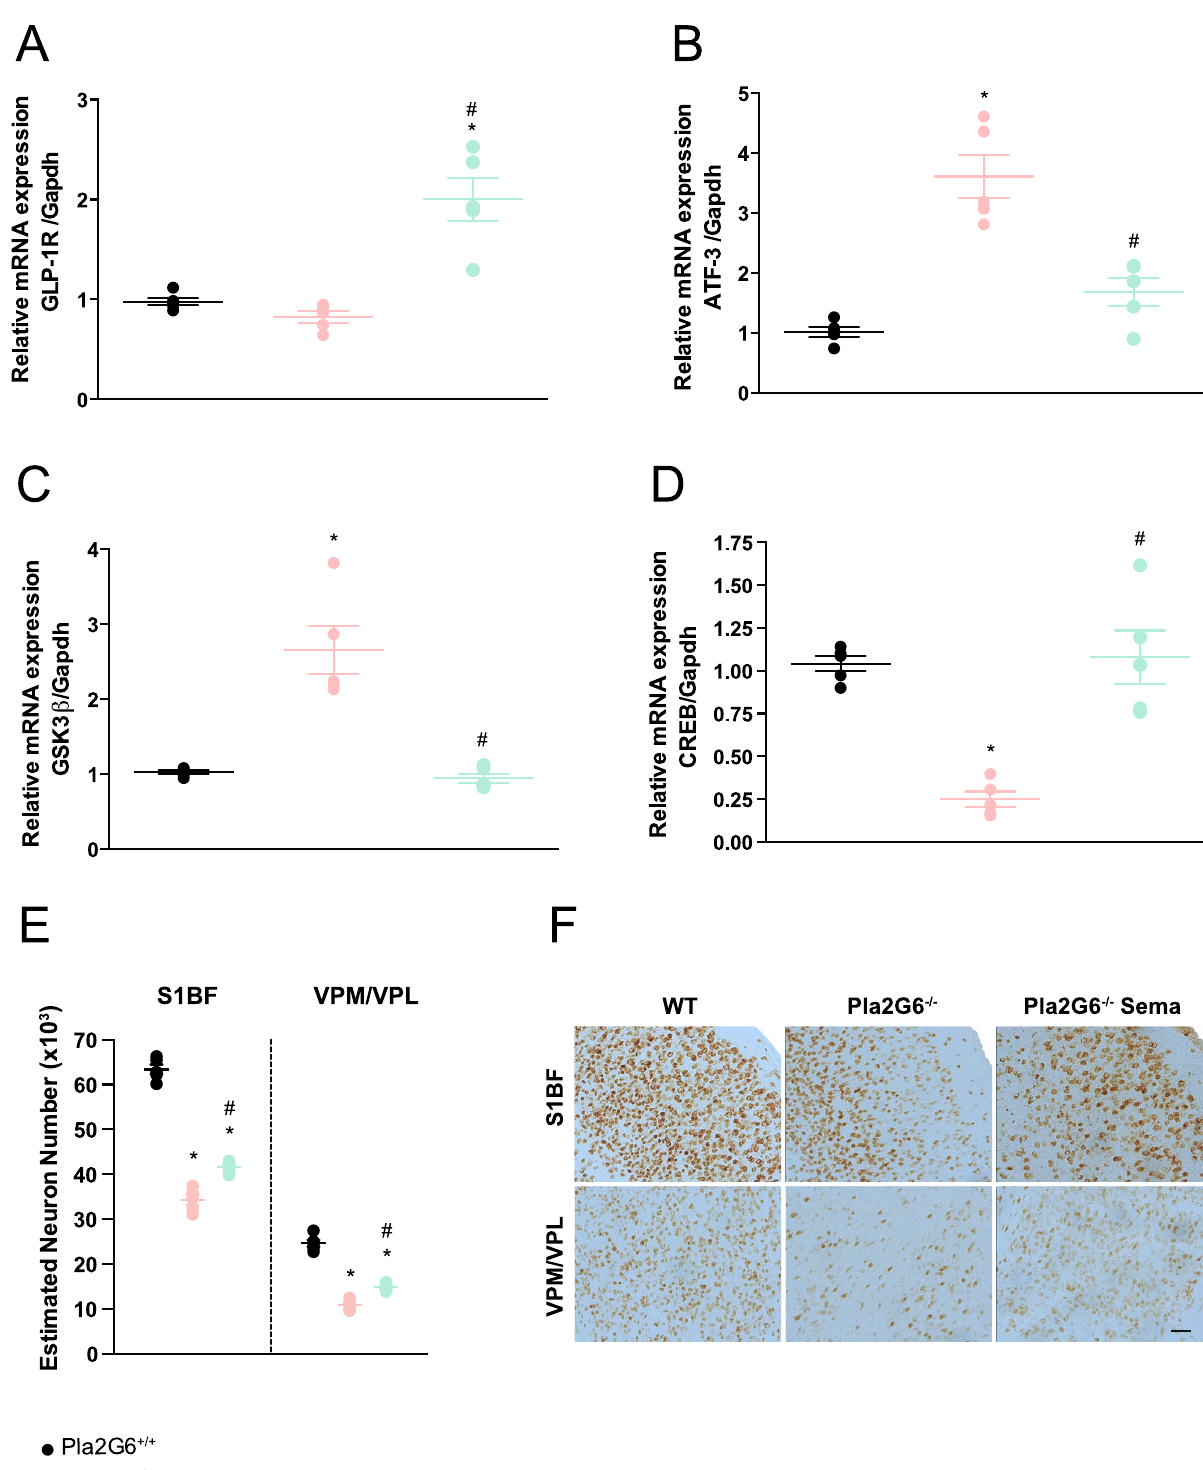
Figure 2. Semaglutide induces neuroprotection and reduces neuronal damage demonstrated by modulation of neuroprotective markers and neuronal damage markers. Relative quantification of ( A ) GLP-1R, ( B ) ATF-3, ( C ) GSK3β and ( D ) CREB, with Gapdh as internal reference by quantitative PCR. RT-qPCR performed from RNA samples prepared from WT, untreated Pla2g6 −/− and treated Pla2g6 −/− Sema brain samples ( n = 5 per group). ( E ) Optical fractionator estimation of NeuN stained neuronal numbers in the somatosensory barrel-field cortex (S1BF) and ventral posteromedial nucleus/ventral posterolateral nucleus (VPM/VPL) of WT, untreated Pla2g6 −/− and treated Pla2g6 −/− ( n = 5 per group) brain sections. ( F ) Representative images of brain sections stained with NeuN. Scale bar = 100 µm. All data are presented as mean (SEM); ordinary one-way ANOVA adjusted using Tukey’s multiple comparisons test; p values reported in Table S5. * indicates statistically significant difference between the relevant experimental group and WT controls; # indicates statistically significant difference between Pla2g6 −/− Sema mice and untreated Pla2g6 −/−